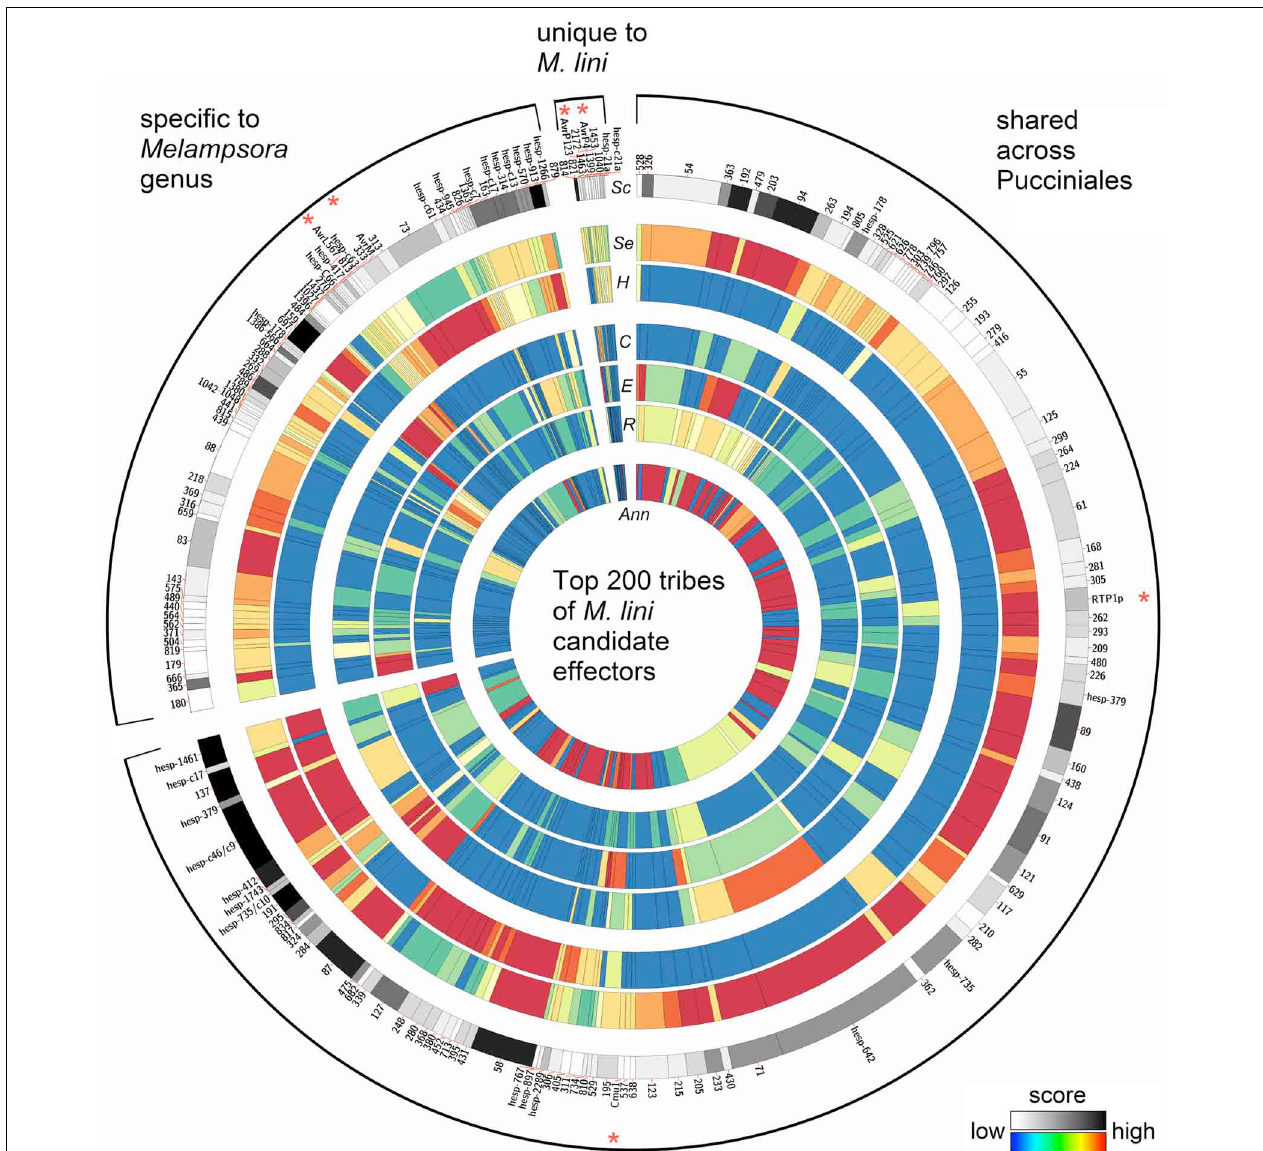
FIGURE 4 | Properties of the top 200 tribes of M. lini candidate effectors. Tribes were assembled with 2642 proteins coming from four rust species ( Mli , Mlp , Pgt , and Pst ), and all contain at least one member from Mli . Tribes were grouped according to whether they contain members from Mli only or members from the two Melampsora species only or members from all four rust species. On a circle, each bar represents a tribe, with the width of bar proportional to the number of members in that tribe. Previously known Mli avirulence proteins and fungal virulence effectors are indicated with a red asterisk. For each tribe, heatmaps indicate the scores for ( Sc ) overall tribe